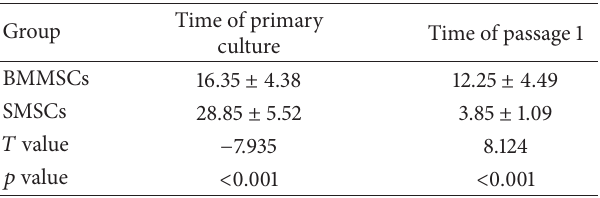
Table 1: Culture times for MSCs isolated from bone marrow and skin (mean ± SD,